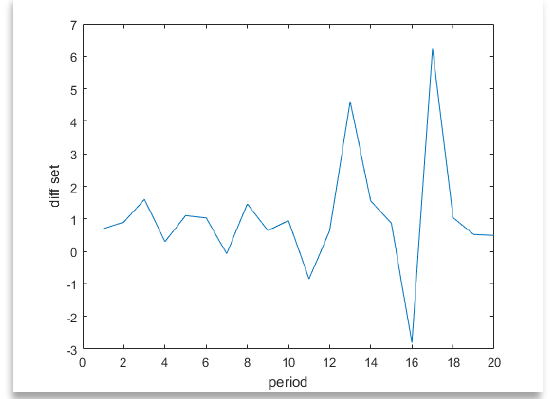
Figure 11. Chart of potential difference data before and potential difference after adjustment .